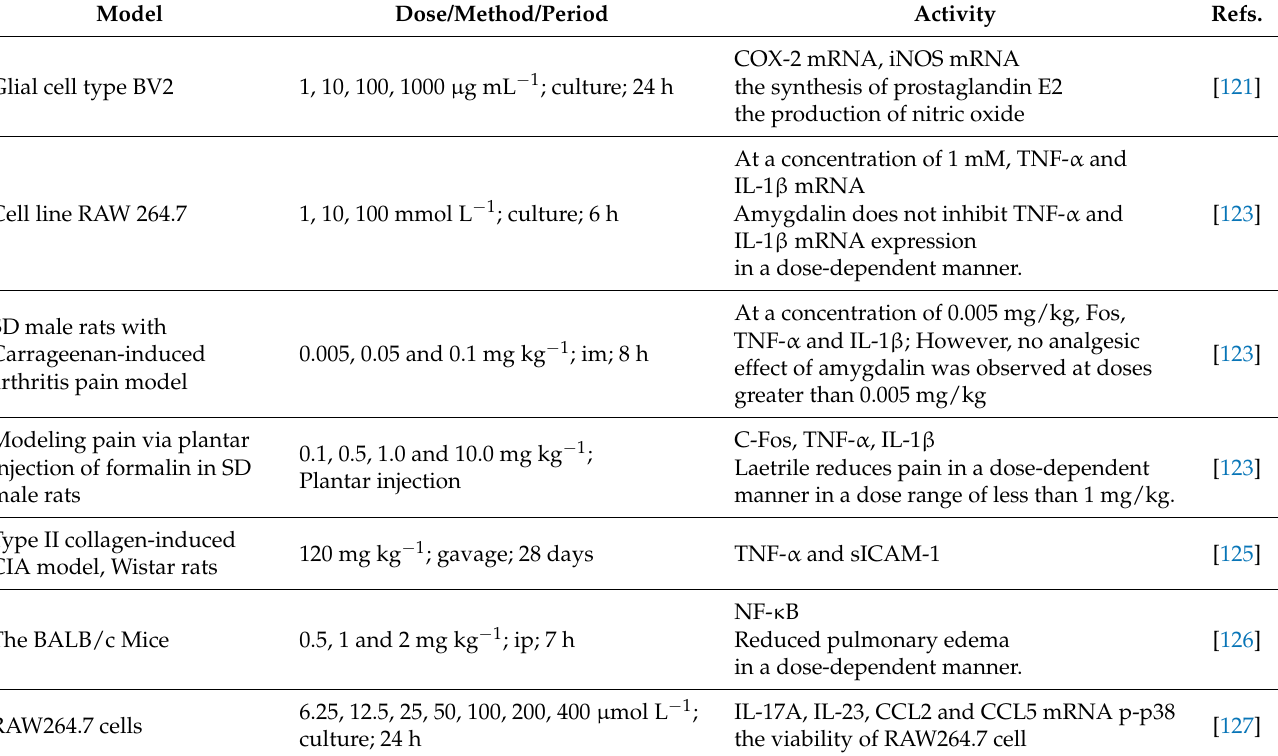
Table 2. Provides a summary of the primary references dealing with its analgesic and anti- inflammatory